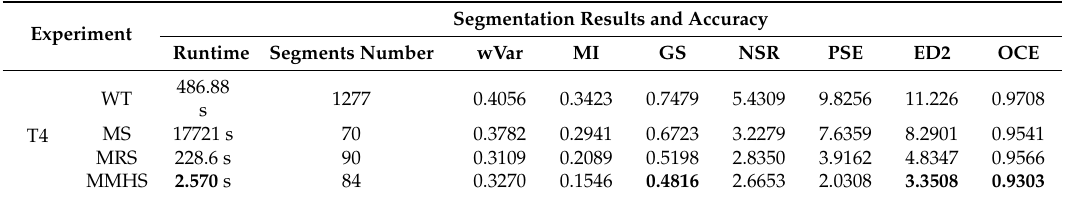
Table 8. The quantitative assessment results of the Potsdam aerial image (T4).